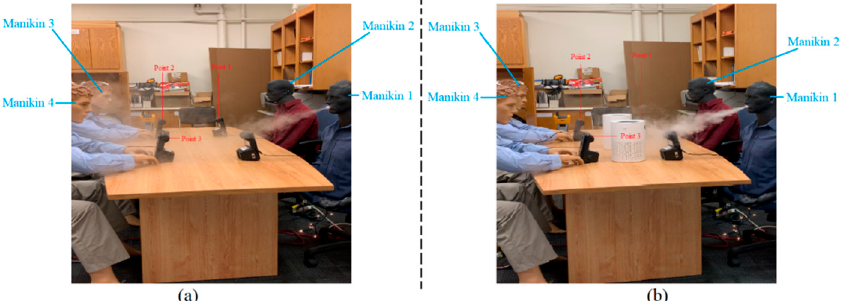
Figure 1. Lab experiment of the single table case: ( a ) without air purifiers; ( b ) with air purifiers.